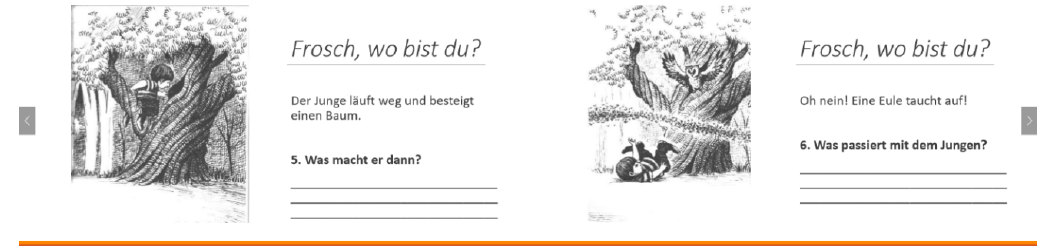
Figure A7. Pretest: Production task.